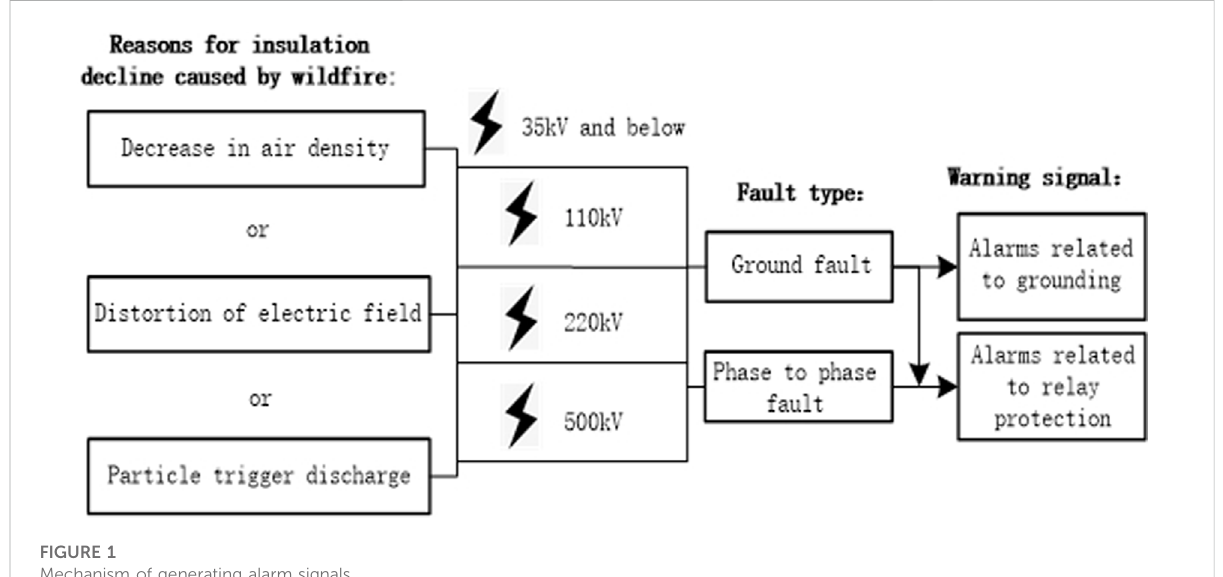
FIGURE 1 Mechanism of generating alarm